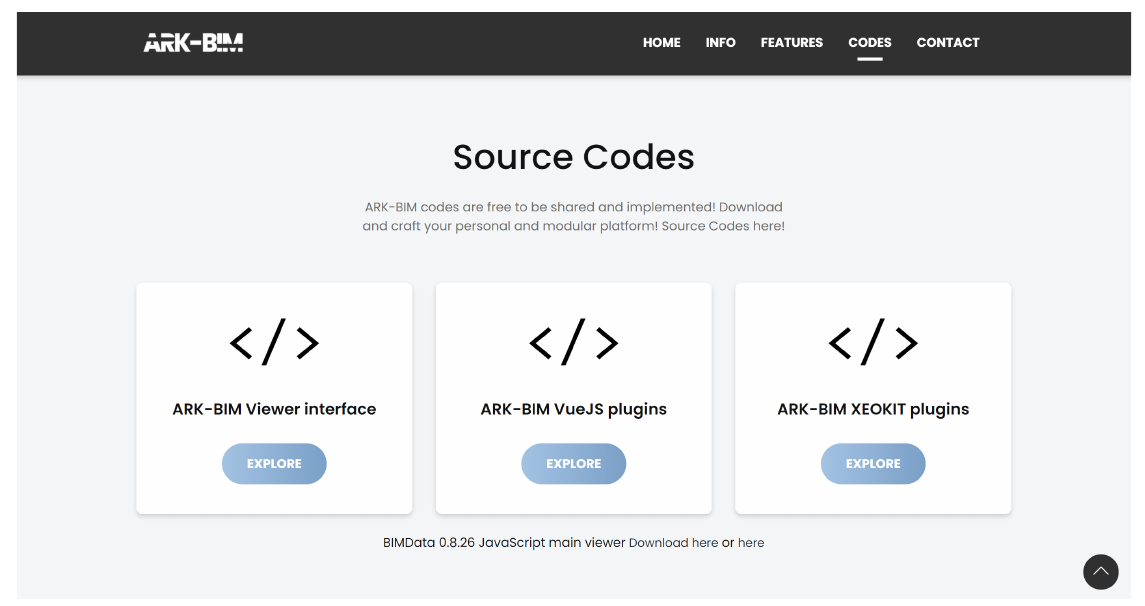
Figure 21. ARK-BIM website. Source code section; codes are free to be shared and utilized.